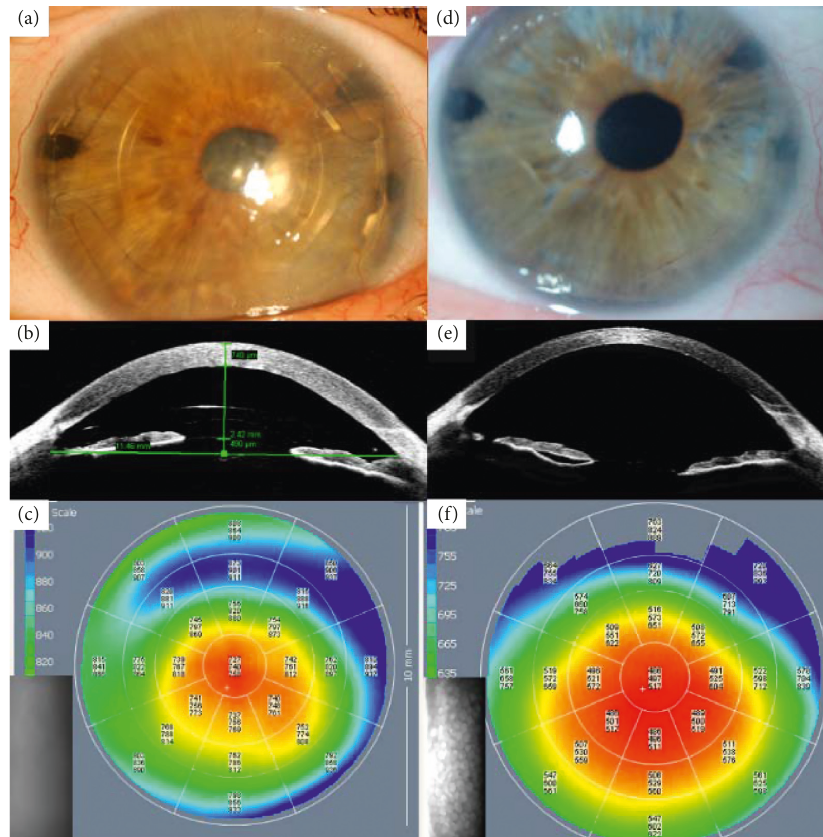
Figure 2: A 59-year-old woman (patient 2) with I-Care pIOL implanted for 21 years underwent bilensectomy followed by Descemet membrane endothelial keratoplasty (DMEK) 1 month later. (a–c) Preoperative slit-lamp and Visante OCT images revealed a decompensated cornea with increased central corneal pachymetry of 740 μ m and uncountable central endothelial cells on the specular microscope. Preoperative uncorrected visual acuity (UCVA) and best-corrected visual acuity (BCVA) were 20/2000 (counting fingers). (d–f) Six months postoperatively, there was a resolution of the corneal edema with improved central pachymetry to 497 μ m and endothelial cell density of 870 cells/mm 2 . UCVA increased to 20/44 (0.45) and BCVA to 20/30 (0.65), being an amblyopic